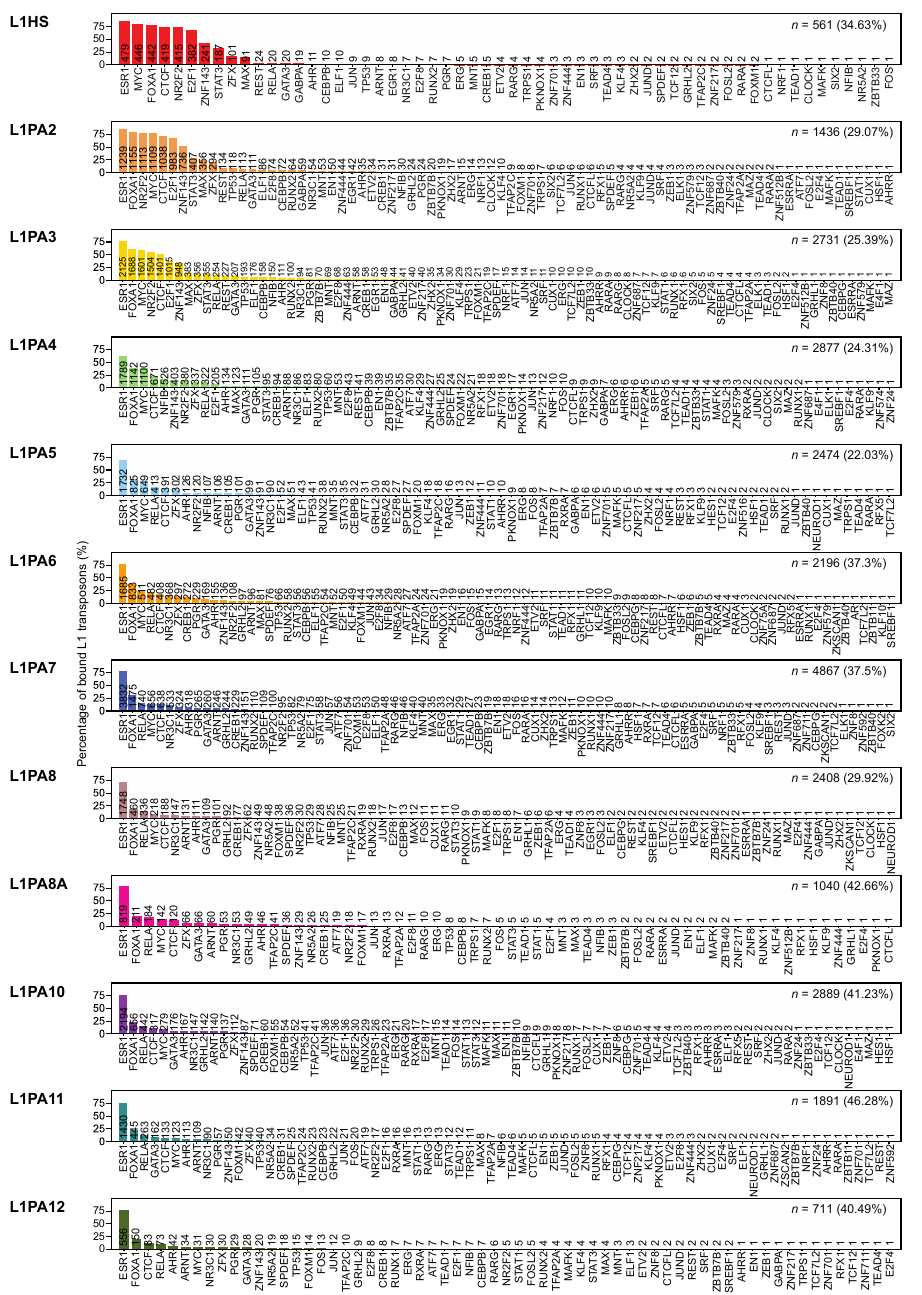
Figure 2 . L1 transposon subfamilies harbour abundant TF binding activities in MCF7 cells. Bar graphs show the percentages of TF-bound L1 transposons harbouring TFBSs for each TF, labelled with the corresponding numbers of L1 transposons containing TFBSs. For each subfamily, the total TF-bound transposons are shown as the count ( n ) and the percentage of total L1 transposons in the subfamily.